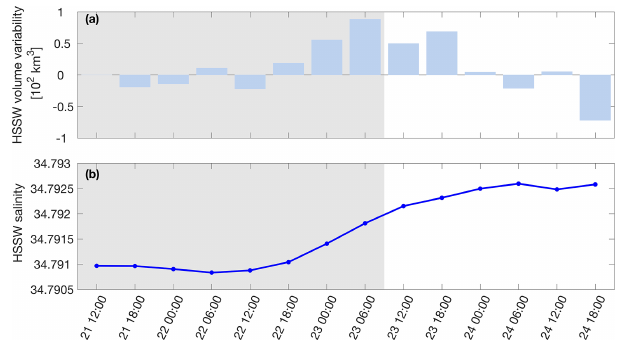
Figure 10. Time series of (a) HSSW volume variability and (b) av- eraged HSSW salinity over the RISP region shown in Fig. 2a from 12:00 on 21 June to 18:00 on 24 June 2005. The gray shading rep- resents the time of the MESO